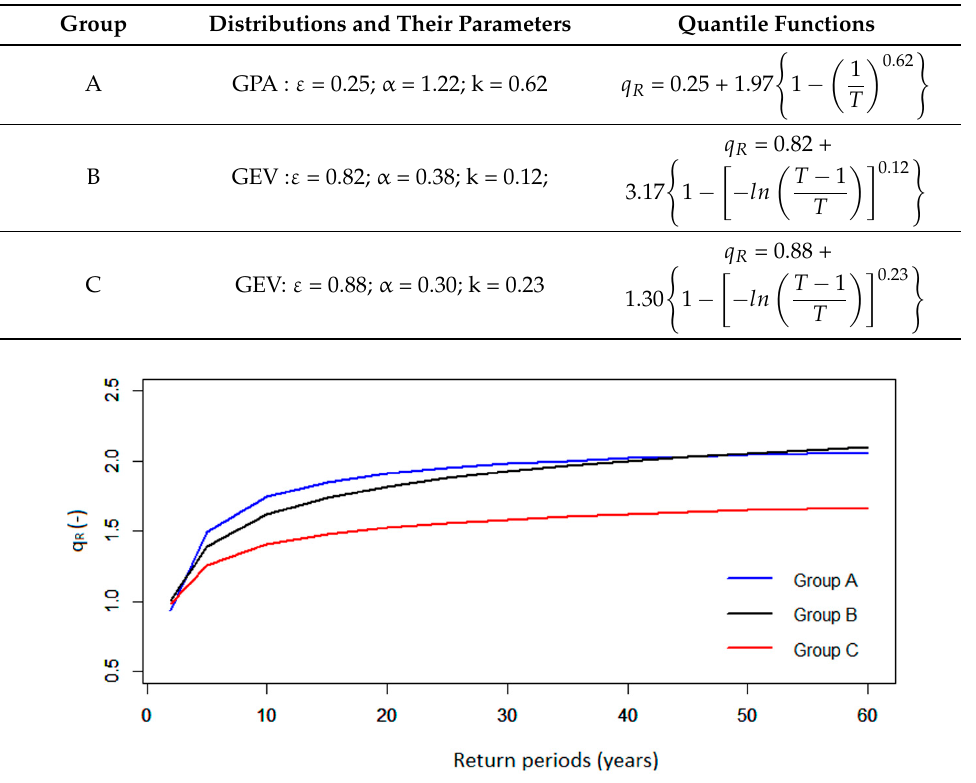
Table 7. Quantile functions of the homogeneous groups.